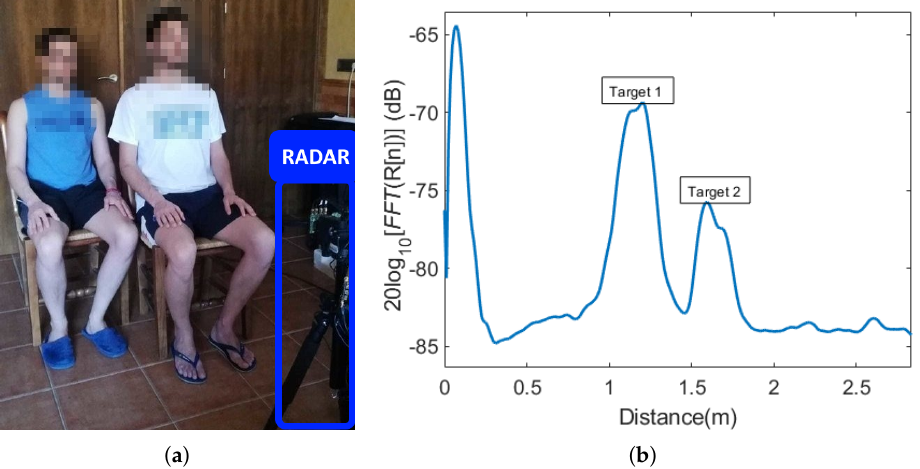
Figure 17. ( a ) Multi-target experiment scenario. ( b ) Frequency spectrum of the captured radar signal, where the two targets are clearly separated at 1.2 and 1.6 m.